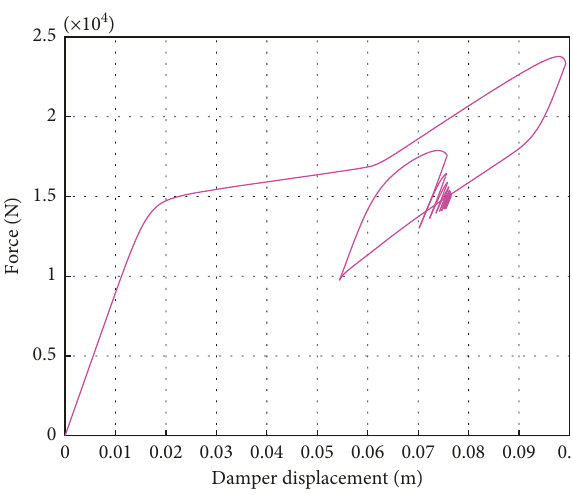
Figure 11: Damper response.